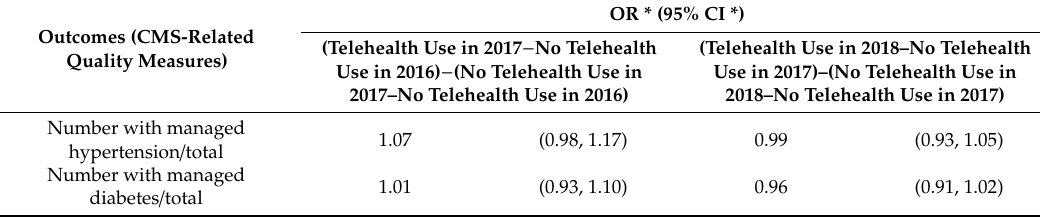
Table 3. Analyzing the associations between telehealth use and the management of cardio-metabolic syndrome-related quality measures, employing the di ff erence in di ff erence